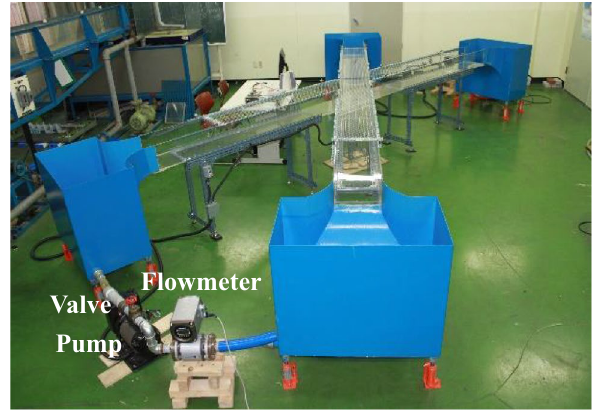
Fig. 3 Set-up of the hydraulic-experiment